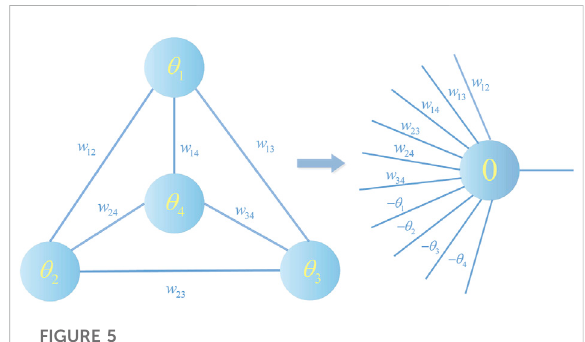
FIGURE 5 HNN and perceptual model transformation relationship.